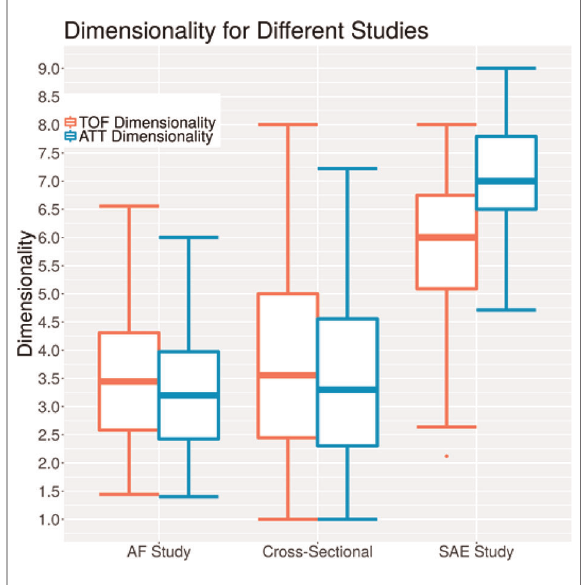
FIGURE 13 Dimensionalities for different acoustocerebrography-based studies; the y -axis is the dimensionality value, the x -axis represents the study, the TOF-based dimensionality is in red, and the ATT-based dimensionality is in